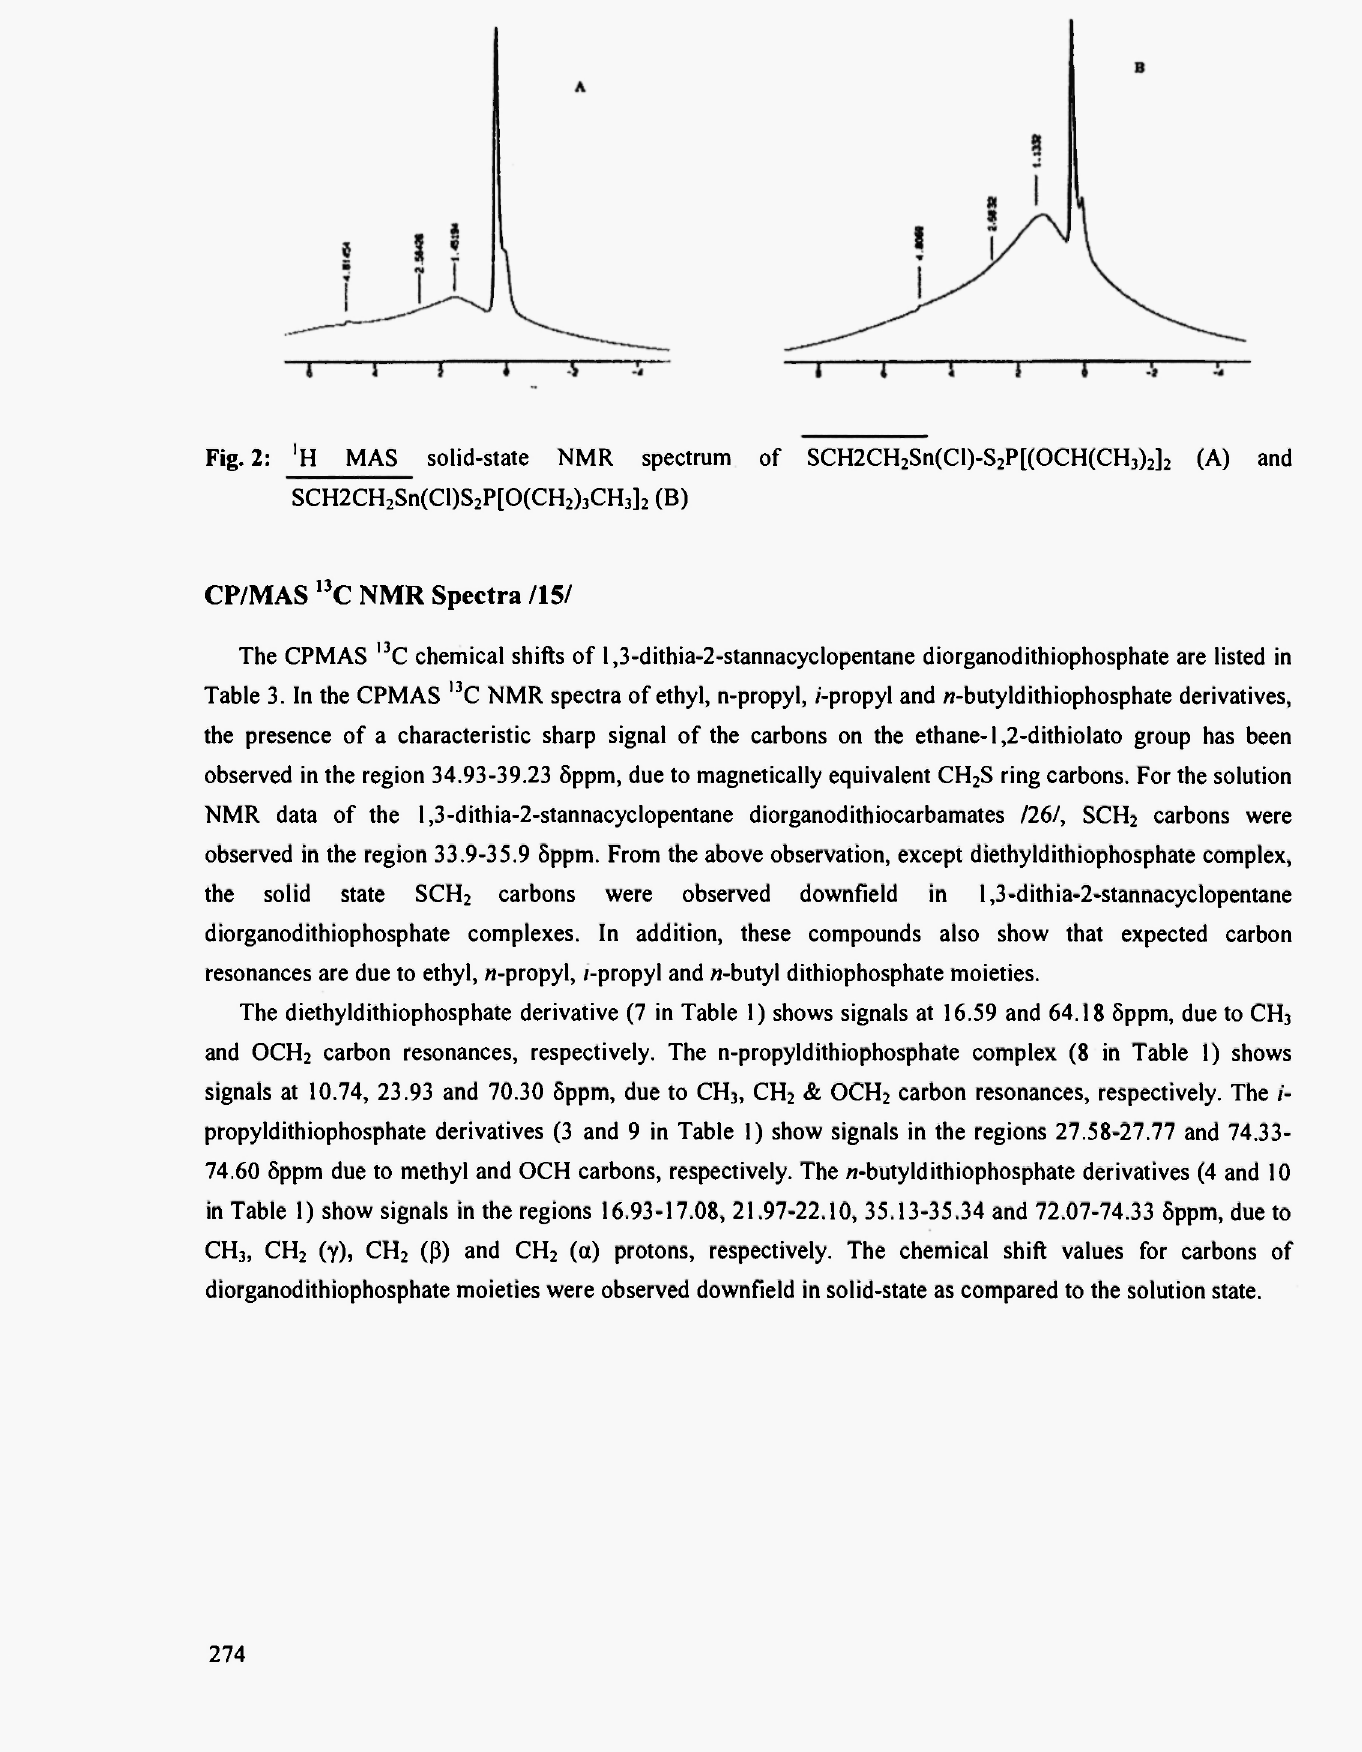
Fig. 2: 'H MAS solid-state NMR spectrum of SCH2CH 2 Sn(Cl)-S 2 P[(OCH(CH 3 ) 2 ]2 (A) and SCH2CH 2 Sn(Cl)S 2 P[0(CH 2 ) 3 CH 3 ] 2 (B)